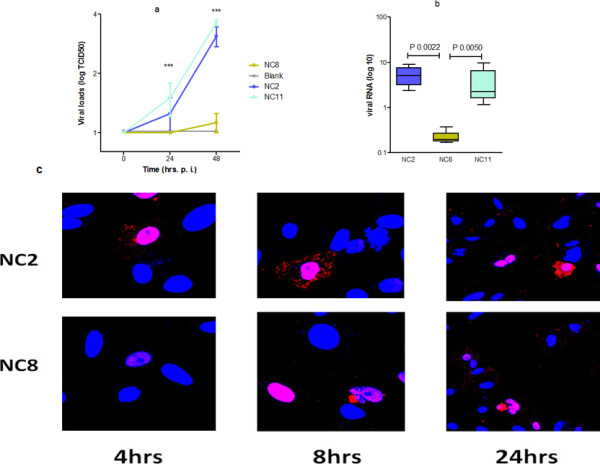
Comparison of viral replication kinetics in A549 cells. A549 cells were infected with viral strains; NC2, NC8 and NC11 at MOI 2. (a) shows the viral titers in cell supernatants 24 and 48 h post infection (P < 0.0001). (b) shows viral mRNA levels in infected cells and (c) Nuclear localization of viral NP protein was noticeably slow in cases of NC8 infection at 4 h that led to no or negligible yield of viral progeny in cell cytoplasm at 8 h post infection. Red shows staining of viral NP protein and blue shows nucleus specific DAPI stain. Micrographs are taken at the magnification of 40 (for 4 h and 8 h) and at 20 for 24 h.